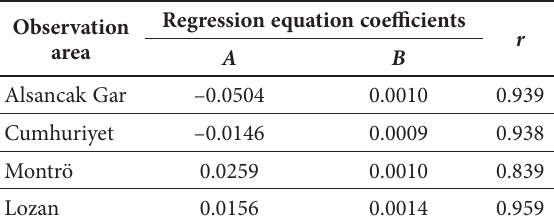
Table 4. Results of the regression analysis of multi-lane traffi c circles